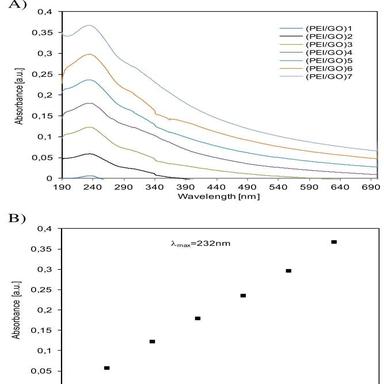
(A) UV–Vis absorption spectra for (PEI/GO)n multilayer films. (B) The dependence of the absorbance at λmax = 232 nm for (PEI/GO)n.